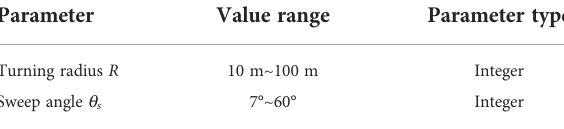
TABLE 2 Design space in rotating arm pool experiment.